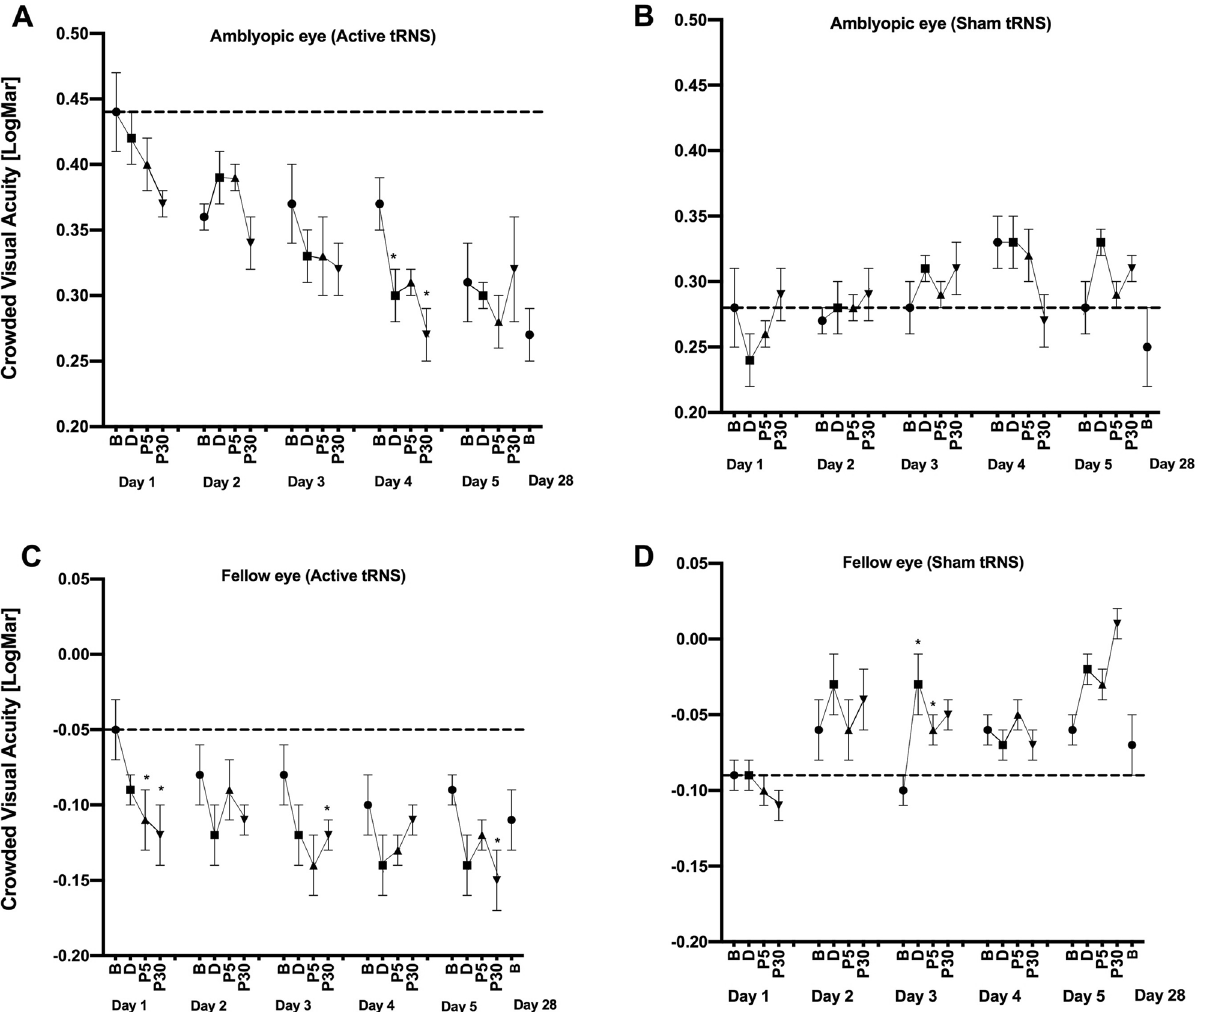
Figure 6. The effects of tRNS on crowded visual acuity during each daily session and at the day 28 follow-up visit. Data are shown as in Fig. 3. Lower (smaller/more negative) y-axis values indicate better crowded visual